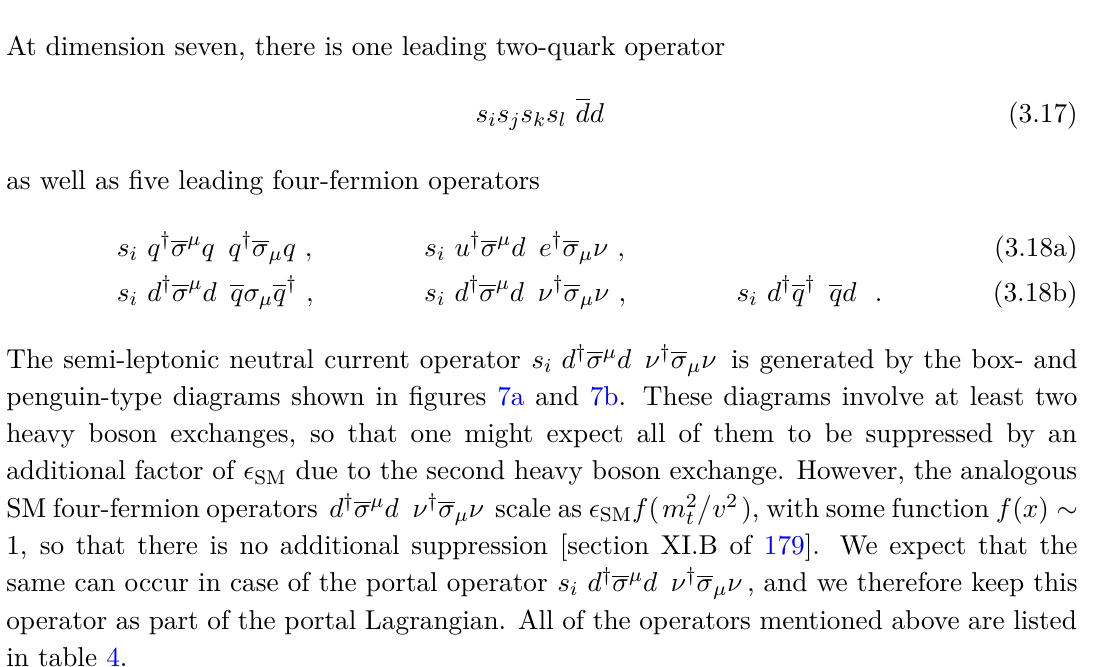
v µ ψ † σ µ ψ (a) Type (i) quark-flavour conserving portal operators of dimension three, four, and five. Table 4. List of all LO strong scale portal operators up to dimension seven that couple LEFT to messenger fields of spin 0, 1 , or 1. Panel a shows operators that contribute to type (i) diagrams and 2 panel b shows operators that contribute to type (ii) diagrams. See also figure 6 for more details. The first column specifies the spin of the messenger field, the second column contains the dimension d of the operators and the remaining columns label the SM sectors they interact with. A generic SM fermion is labelled by ψ = u , d , e , ν , the down-type quarks are d = d, s, the leptons are e = e, µ and ν = ν e , ν µ , ν τ , and q runs over all three light quarks u, d and